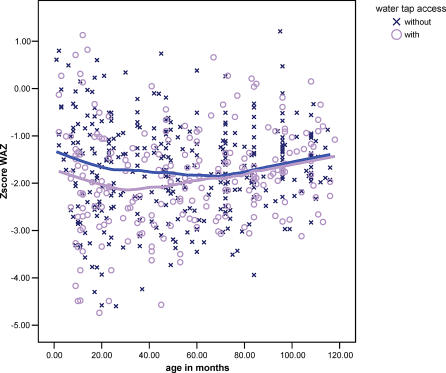
Z-Scores for Weight for Age in Children Aged 0–10 y by Water Tap AccessDataset includes
n = 350 without taps and
n = 227 with taps.